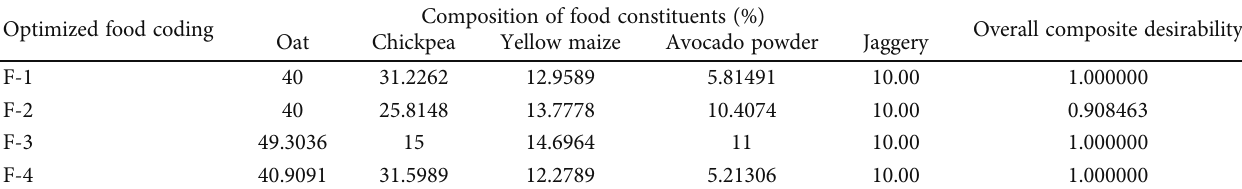
Table 5: Response optimization using Minitab D-optimizer for formulated food. Optimized food